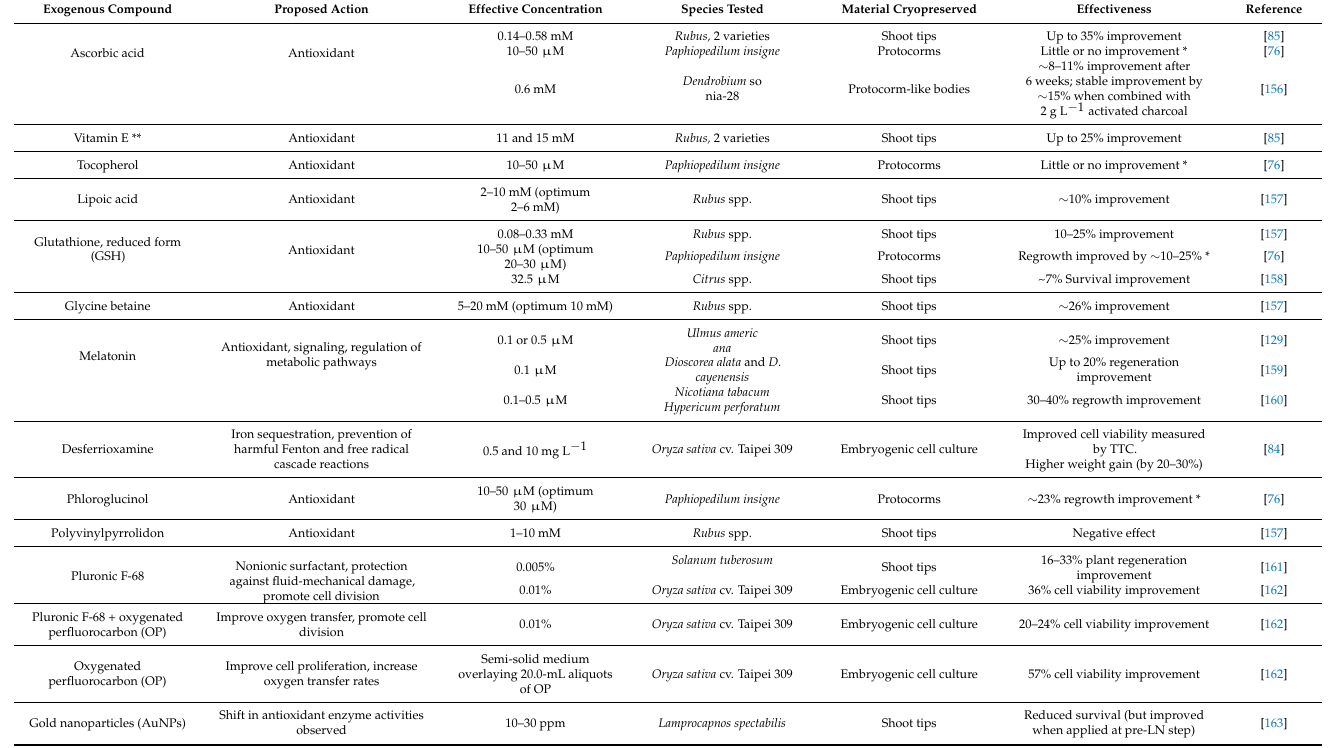
Table 2. The use of the exogenous compounds with antioxidant and detoxifying potential at the recovery step after cryopreservation of different plant species and material